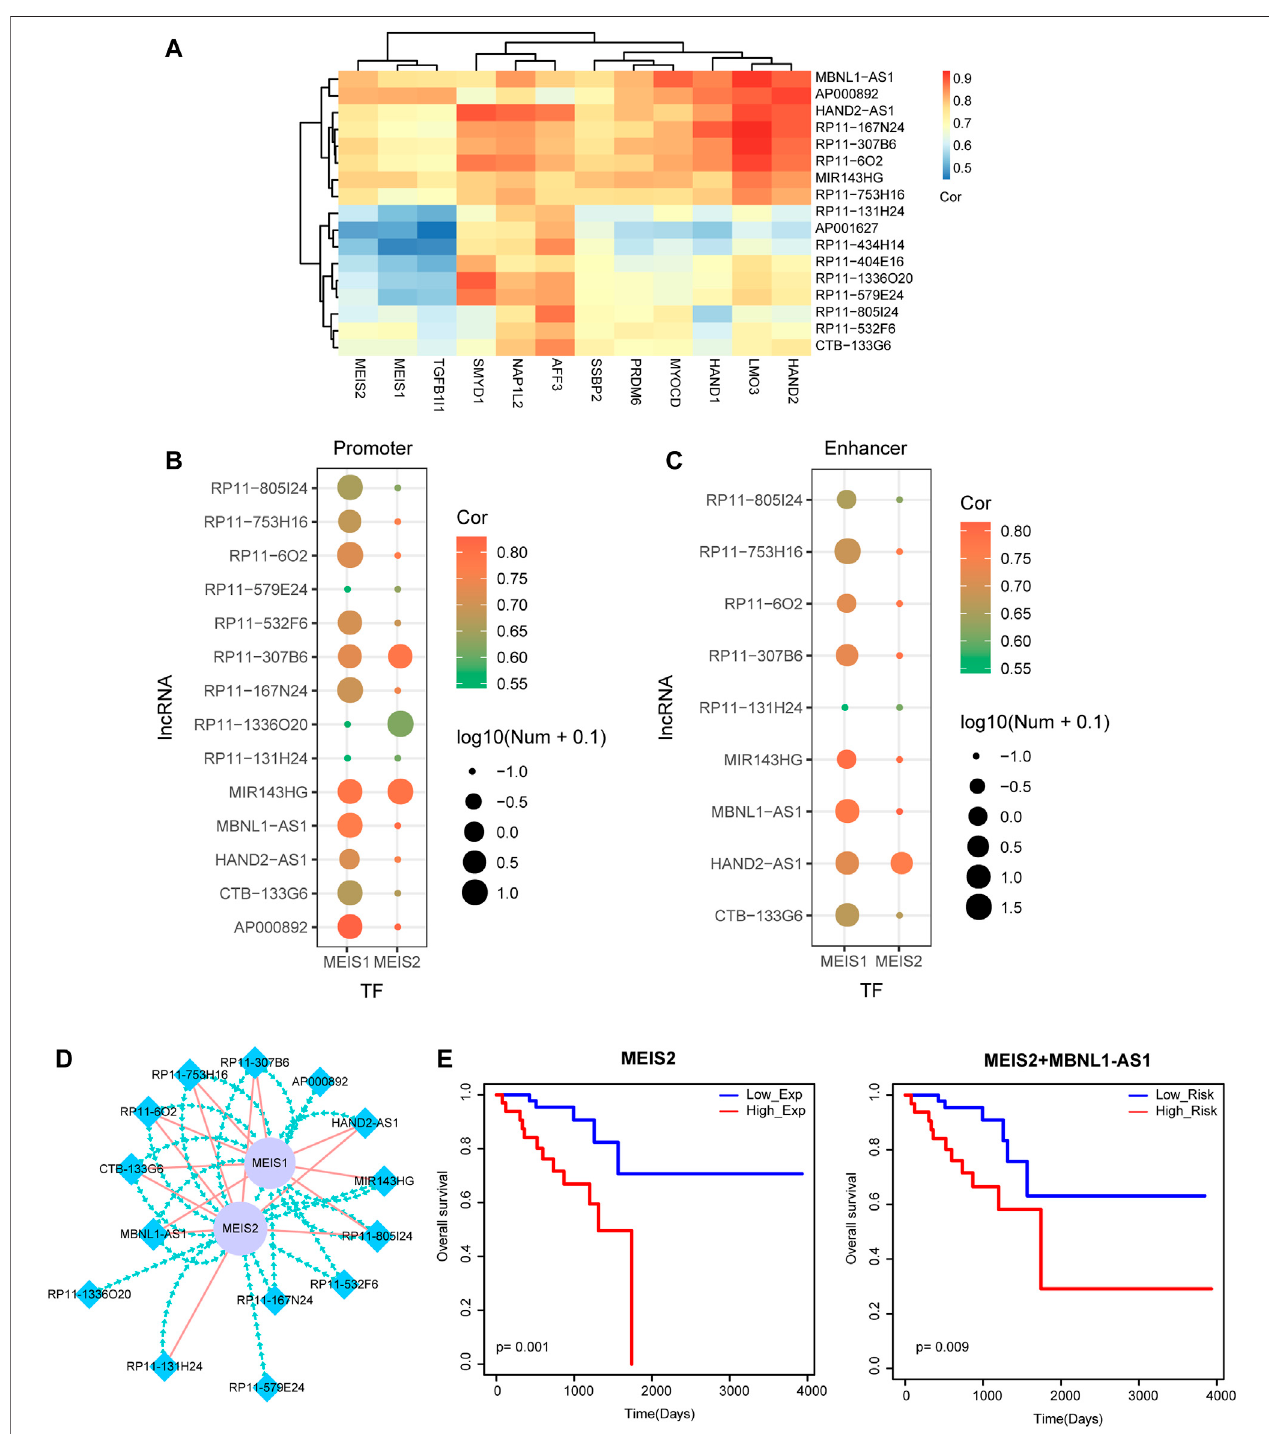
FIGURE 5 | Identi fi cation of TF-lncRNA crosstalk based on motif analysis. (A) The heat map of TF-lncRNA pairs with a threshold of hypergeometric test p -value < 0.05. (B) TFmotif searching ofpromoter regions oflncRNAs.Node color represents thecorrelationscore ofPCC. Nodesize representsthe number ofTFs that bindto the promoter regions oflncRNAs. (C) TF motif searching ofenhancer regionsoflncRNAs.Node color represents the correlation scoreofPCC. Node sizerepresentsthe number of TFs that bind to the enhancer regions of lncRNAs. (D) Visualization of a TF-lncRNA crosstalk network. Blue diamond nodes represent lncRNAs and purple circular nodes represent TFs. Green lines represent TFs binding to the promoter regions of lncRNAs. Red lines represent TFs binding to the enhancer regions of lncRNAs. (E) Kaplan-Meier survival curves of MEIS2 and the combination of MEIS2 and MBNL1-AS1 .